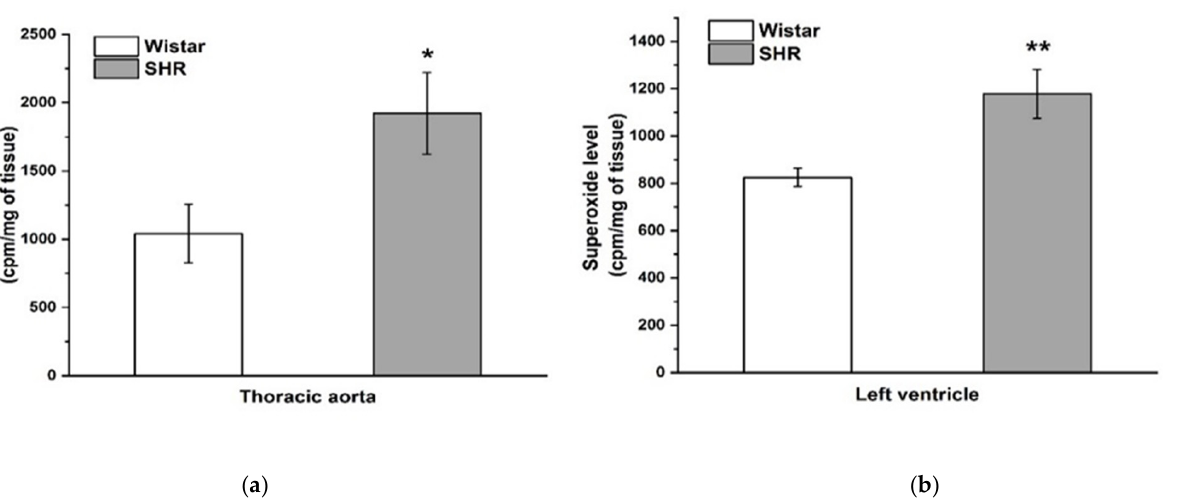
( b ) Figure 5. The level of cystathionine γ -lyase protein expression in the thoracic aorta ( a ) and peri- vascular adipose tissue in Wistar and spontaneously hypertensive rats ( b ) . The results are presented as the mean ± S.E.M. 4. Discussion Mutual interaction between PVAT and H 2 S modulates vascular tone under normo- tensive conditions. Under hypertensive conditions, the activity of PVAT and vasoactive effects of H 2 S may be changed. Our findings showed that, in addition to pathological changes developed in essential hypertension, compensatory mechanisms, including the anticontractile action of PVAT, potentiation of the vasorelaxant effect to exogenous H 2 S,